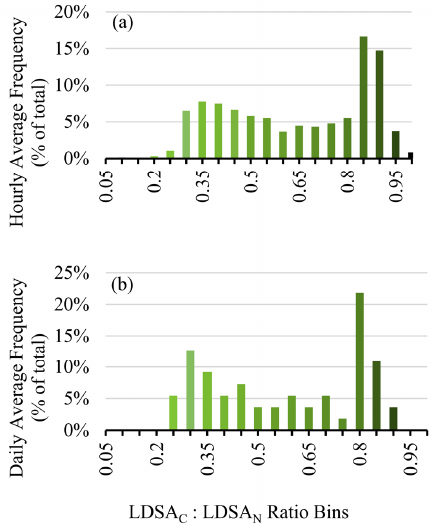
Figure 8. Frequency distribution for the hourly averaged LDSA C to LDSA N ratios on an hourly ( a ) and daily ( b ) basis.